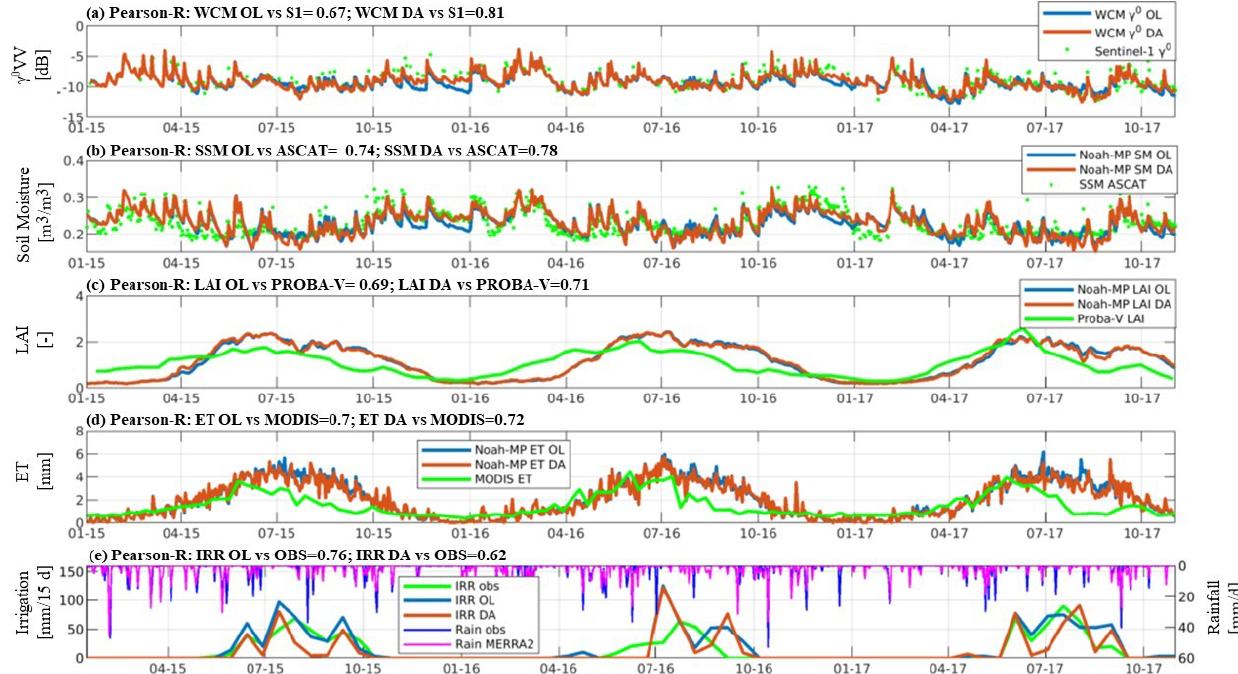
Figure 6. Evaluation of the OL (blue lines) and DA (orange lines) results at the Budrio test site for the Sentinel-1 γ 0 VV DA experiment: (a) Sentinel-1 γ 0 VV against WCM γ 0 VV; (b) ASCAT SSM against simulated SSM; (c) Proba-V LAI against simulated LAI; (d) MODIS ET against simulated ET; and (e) irrigation benchmark against simulated irrigation, with an indication of MERRA2 and in situ rainfall